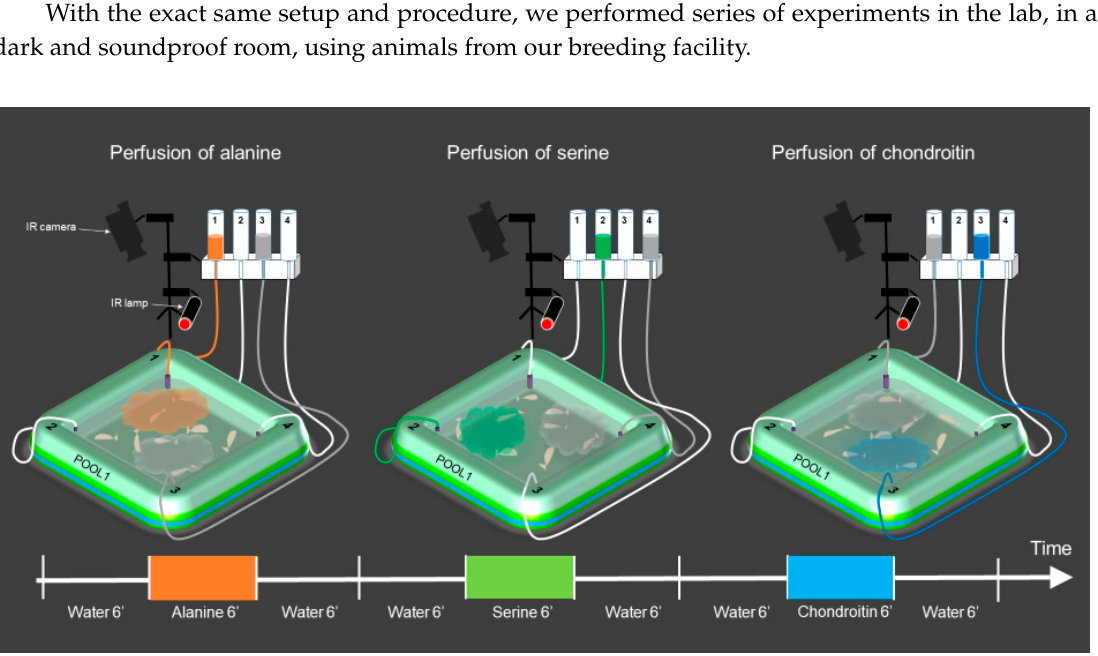
Figure 1. Establishment of a behavioral setup and protocol to test cavefish olfaction in the field. The setup allows testing olfactory responses of eight adult fish in inflatable plastic pools in the dark under infrared recordings. Three different odors were perfused sequentially by gravity flow at different corners of the plastic pool, according to the indicated timeline. See Methods and the first paragraph of Results for details.